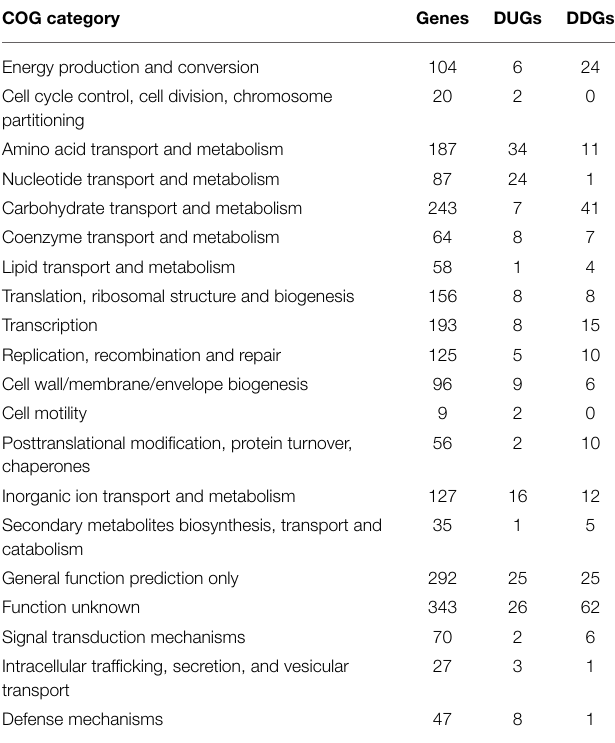
TABLE 3 | Number of genes that were differentially expressed in alkaline stress. COG category Genes DUGs